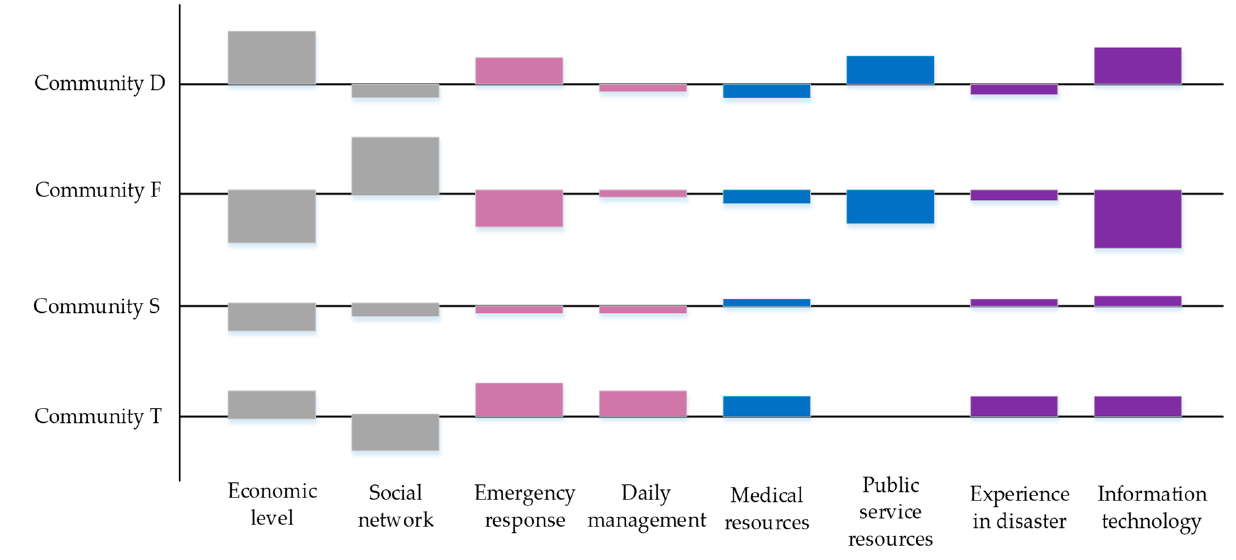
Figure 4. Strengths and weaknesses of each community.